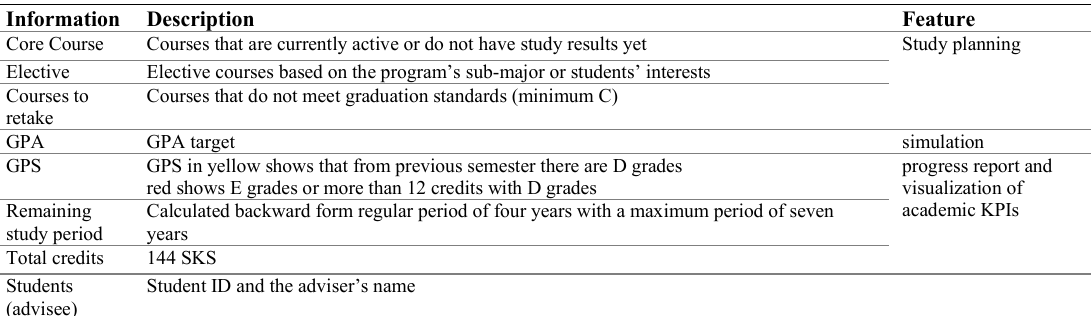
TABLE 2 S YSTEM F EATURES AND OUTPUT I